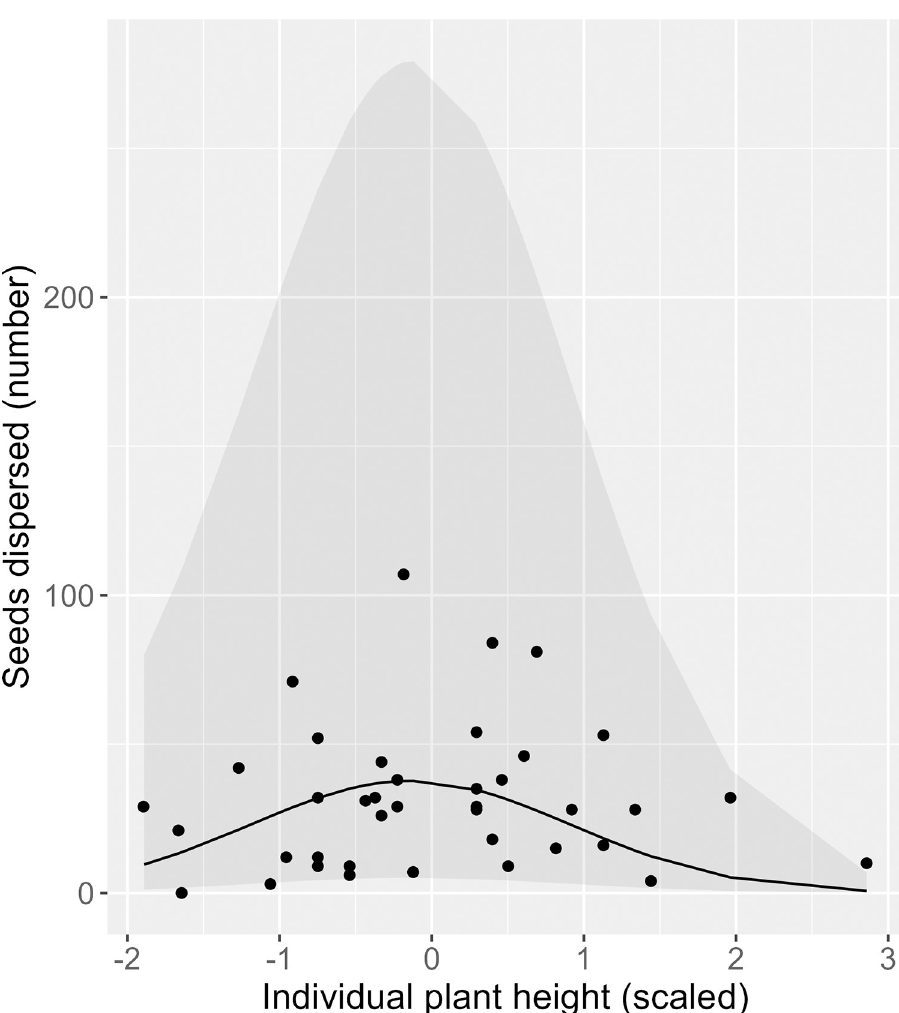
Fig 3. Relationship between the number of Lindera subcoriacea seeds dispersed and individual height (scaled). Points are individual observations, the line is from a mixed-effects generalized linear regression model with a quadratic effect (full model), and the shaded region is the 95% confidence